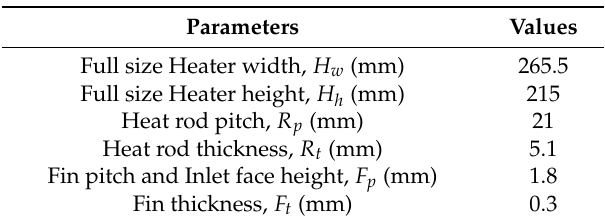
Figure 3. Schematic of simulation model with boundary conditions. Table 1. Geometrical parameter for heater models.